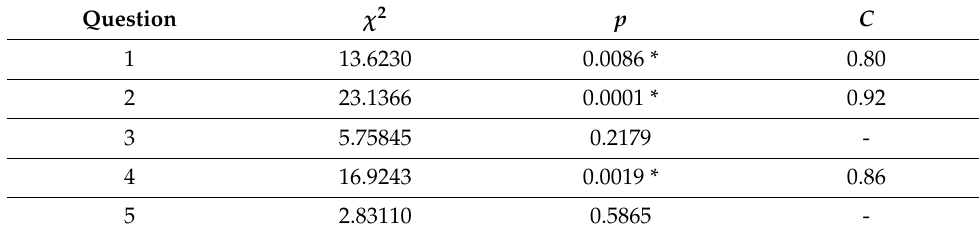
Table 2. Results of the χ 2 test.